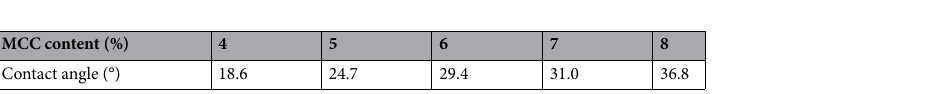
Table 3. Contact angle of membranes with different MCC content in casting